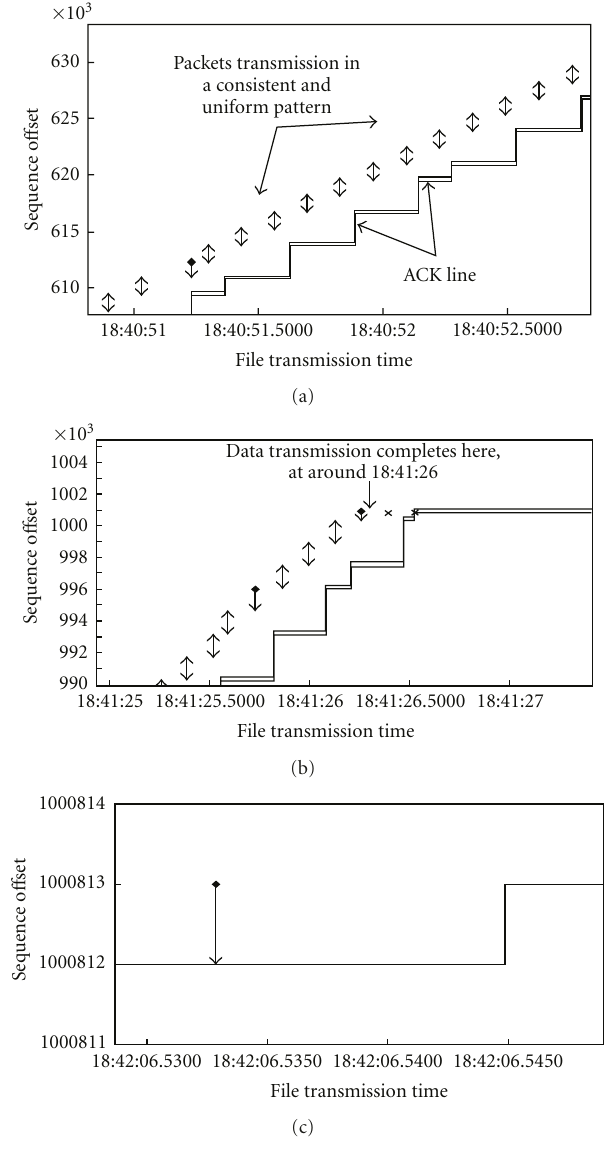
Figure 4: Time Sequence Graph (TSG) for DTN transmission of 1Mbyte from TX to MX. (a) Consistent and uniform transmission pattern of DTN. (b) Completion of DTN data transmission. (c) One-byte TCPCL keep-alive message